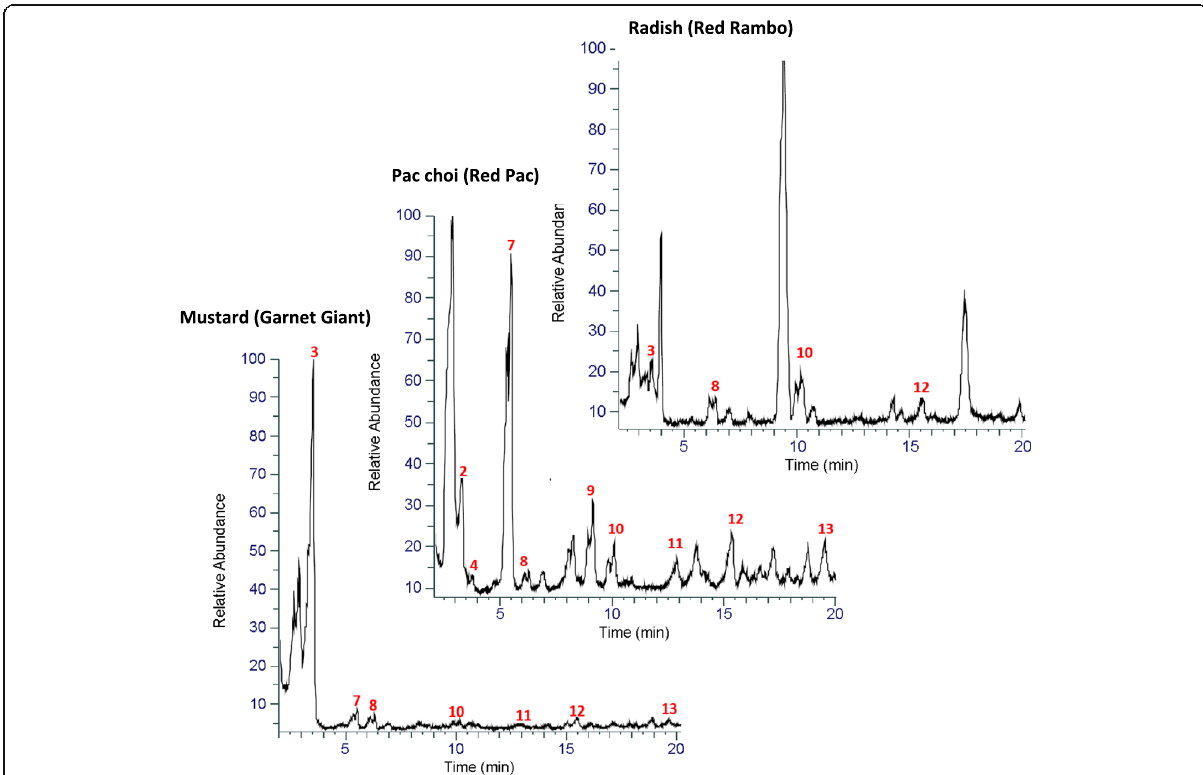
Fig. 1 Relative peak abundance (%) of the extracted ion chromatograms of glucosinolates extracts of representative Brassica microgreens [ B. rapa (Pac choi), B. juncea (mustard) and R. sativus (radish)]. Compounds are 2 progoitrin; 3 sinigrin; 4 glucoraphanin; 7 gluconapin; 8 4- hydroxyglucobrassicin; 9 glucoerucin; 10 glucobrassicin; 11, gluconasturtiin; 12, 4-methoxyglucobrassicin; 13,